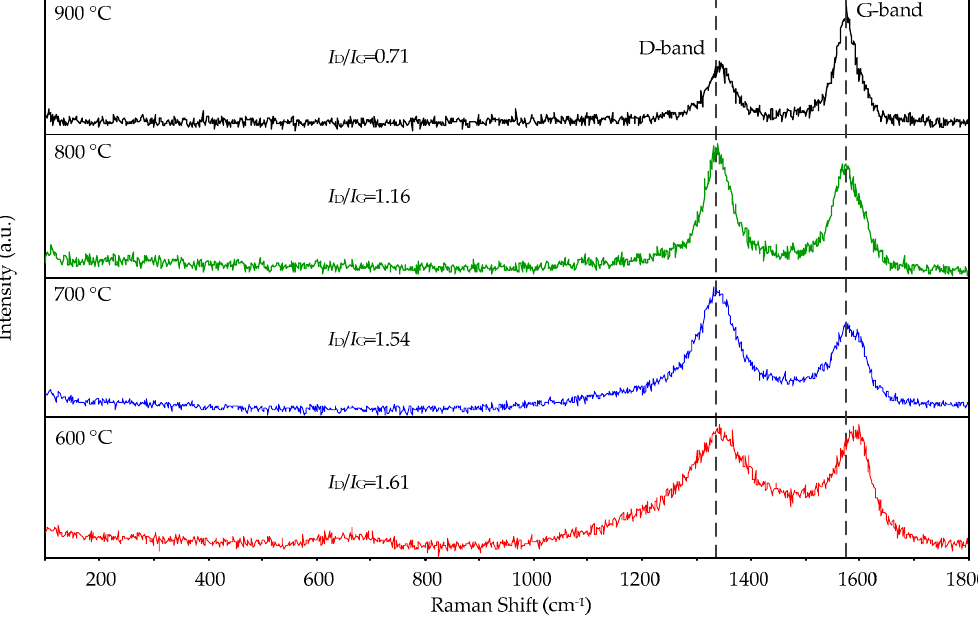
Figure 6. Raman spectra of the CNTs grown on the aluminum foils by the AMPCVD at 600, 700, 800, and 900 °C. The surface purity of the growth CNTs at 900 °C was investigated by XPS measure- ment. The XPS spectra show that the CNTs contain C, O, and N elements, as shown in Figure 7a. Figure 7b shows the magnified view of the C1s peak, indicating that the main components are C–C/C = C (284.6 eV, 80.46%), and the surface defects are hydroxyl (–C– OH/–C–N, 286.0 eV, 19.54%). The hydroxyl groups attached on the CNTs’ surface were mainly from the decomposition of the ethanol precursor.